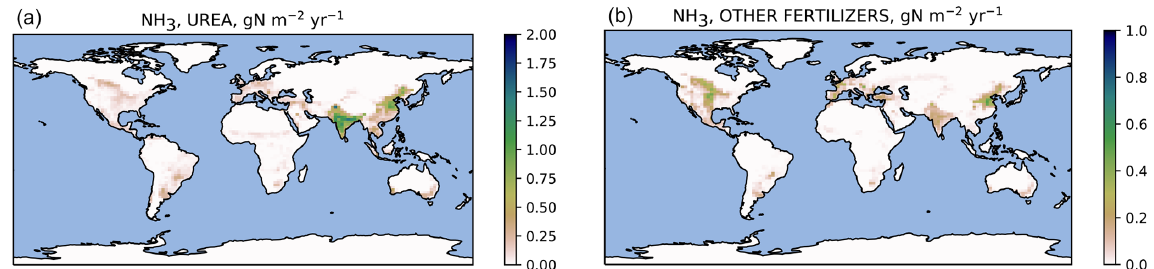
Figure 6. Simulated ammonia emissions (gNm − 2 yr − 1 ) from urea (a) and other synthetic fertilizers (b) averaged over 2010–2015. Note the different color